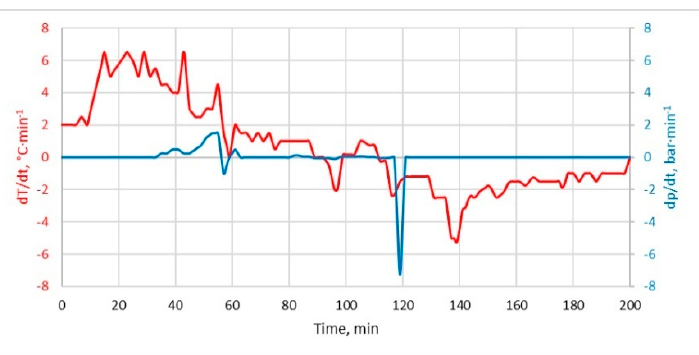
/ pressure patterns during the torrefaction of all Figure A2. Derivatives of temperature/pressure patterns during the torrefaction of all experiments. Figure A2. Derivatives of temperature